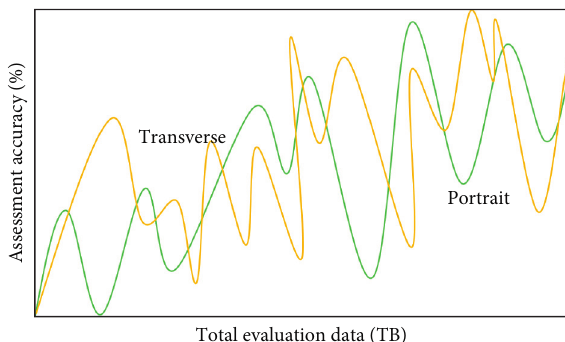
Figure 8: Accuracy of risk assessment of transverse and longitudinal sports